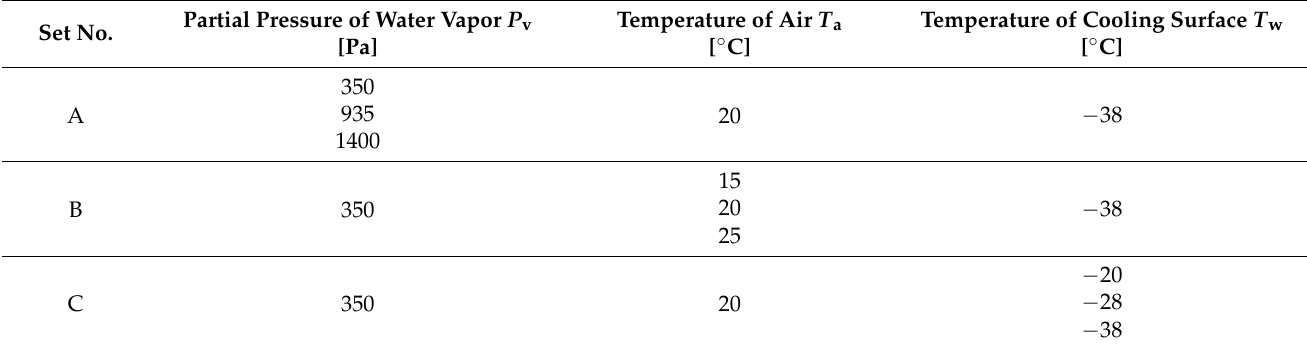
Table 2. Test conditions in the three sets of frosting experiments.